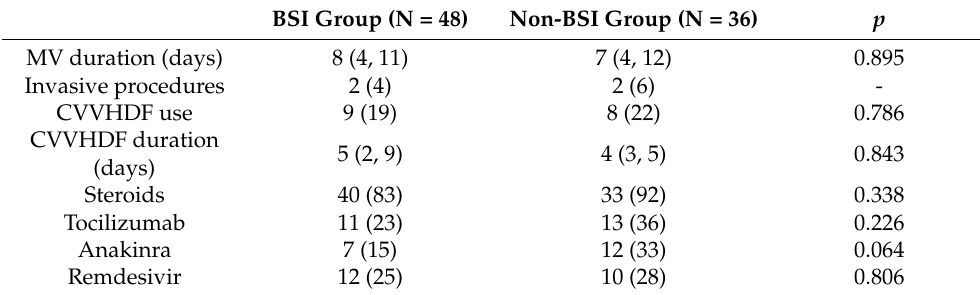
Table 2. Clinical characteristics in the ICU before BSI.